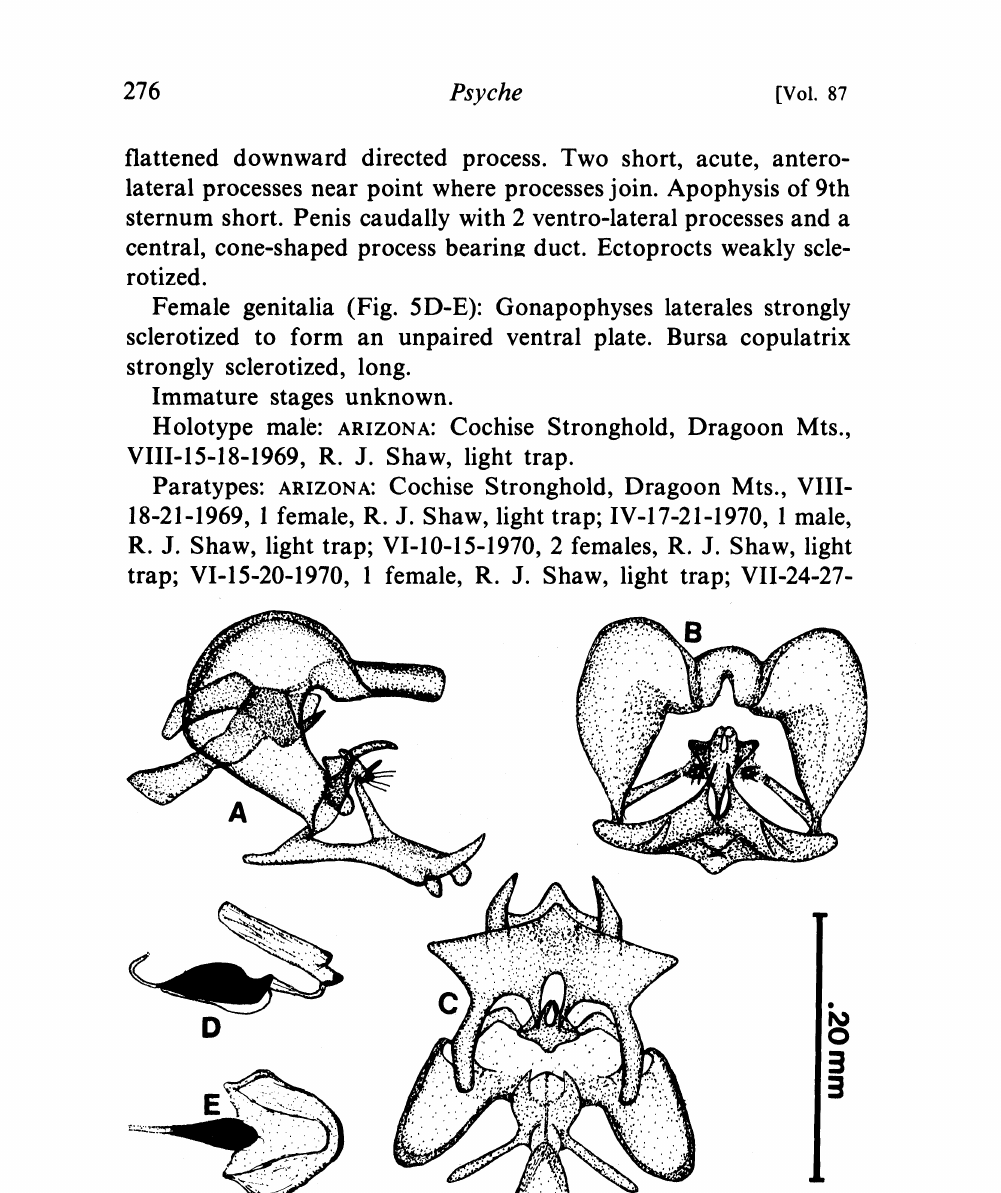
Figure 5. Aleuropteryx dragoonica. A. Male genitalia, lateral view. B. Male genitalia, caudal view. C. Male genitalia, ventral view. D. Female genitalia, lateral view. E. Female genitalia, ventral